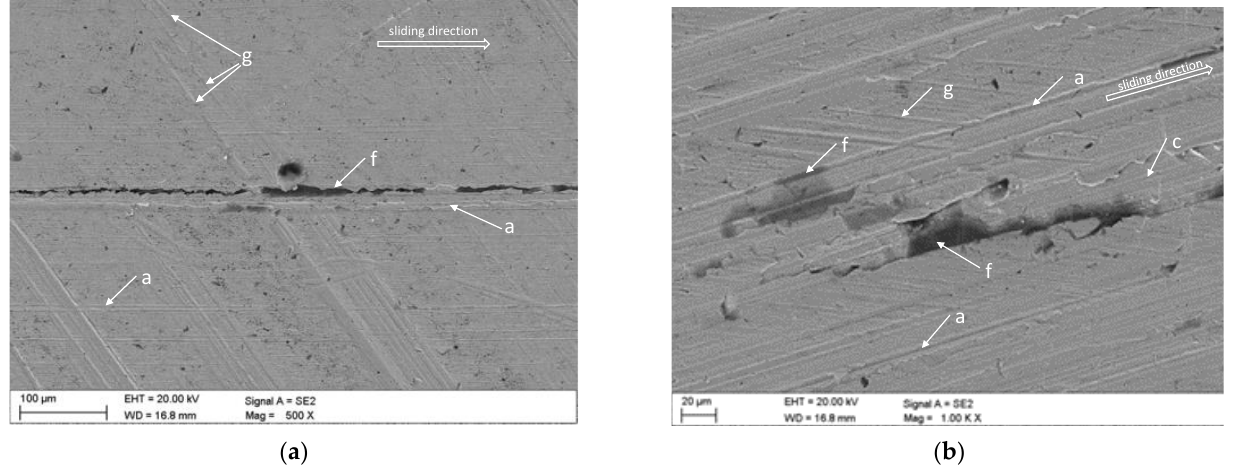
Figure 5. Surface views (SEM) of WRS_400_I steel after wear tests in the presence of coal, ( a )—surface cracking against a background of grinding marks, ( b )—micro-cracks partially filled with coal together with visible chipping; symbols: a—grooves, c—delamination, f—coal-filled surface damage, g—sanding mark.